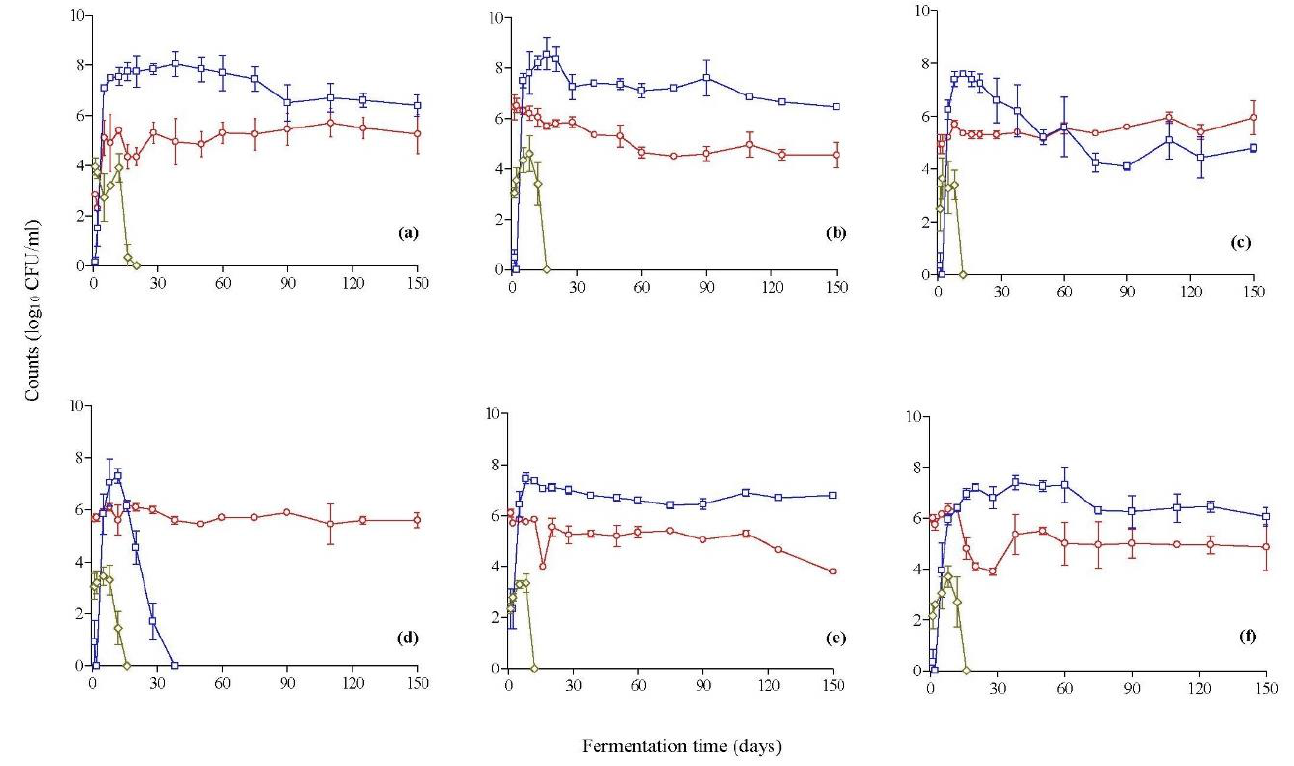
Figure 1. Changes in the population of LAB ( (cid:3) ), yeasts ( ), and Enterobacteriaceae ( ♦ ) in the brines during the inoculated fermentation of cv. Kalamata natural black olives with yeast starters. ( a ) Spon- taneous fermentation (control), ( b ) C. boidinii Y27, ( c ) C. boidinii Y28, ( d ) C. boidinii Y30, ( e ) C. boidinii Y31, and ( f ) S. cerevisiae Y34. Data points are mean values of duplicate fermentations ± standard deviation.